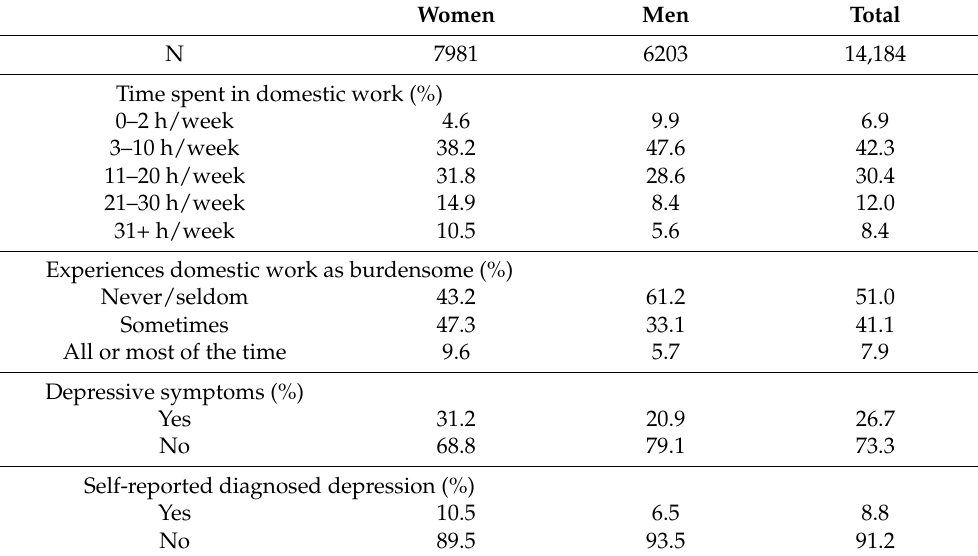
Table 1. Number of respondents, distribution of time spent in domestic work, burdensome domestic work, and the prevalence of depressive symptoms and self-reported diagnosed depression in women and men aged 30–69 years.